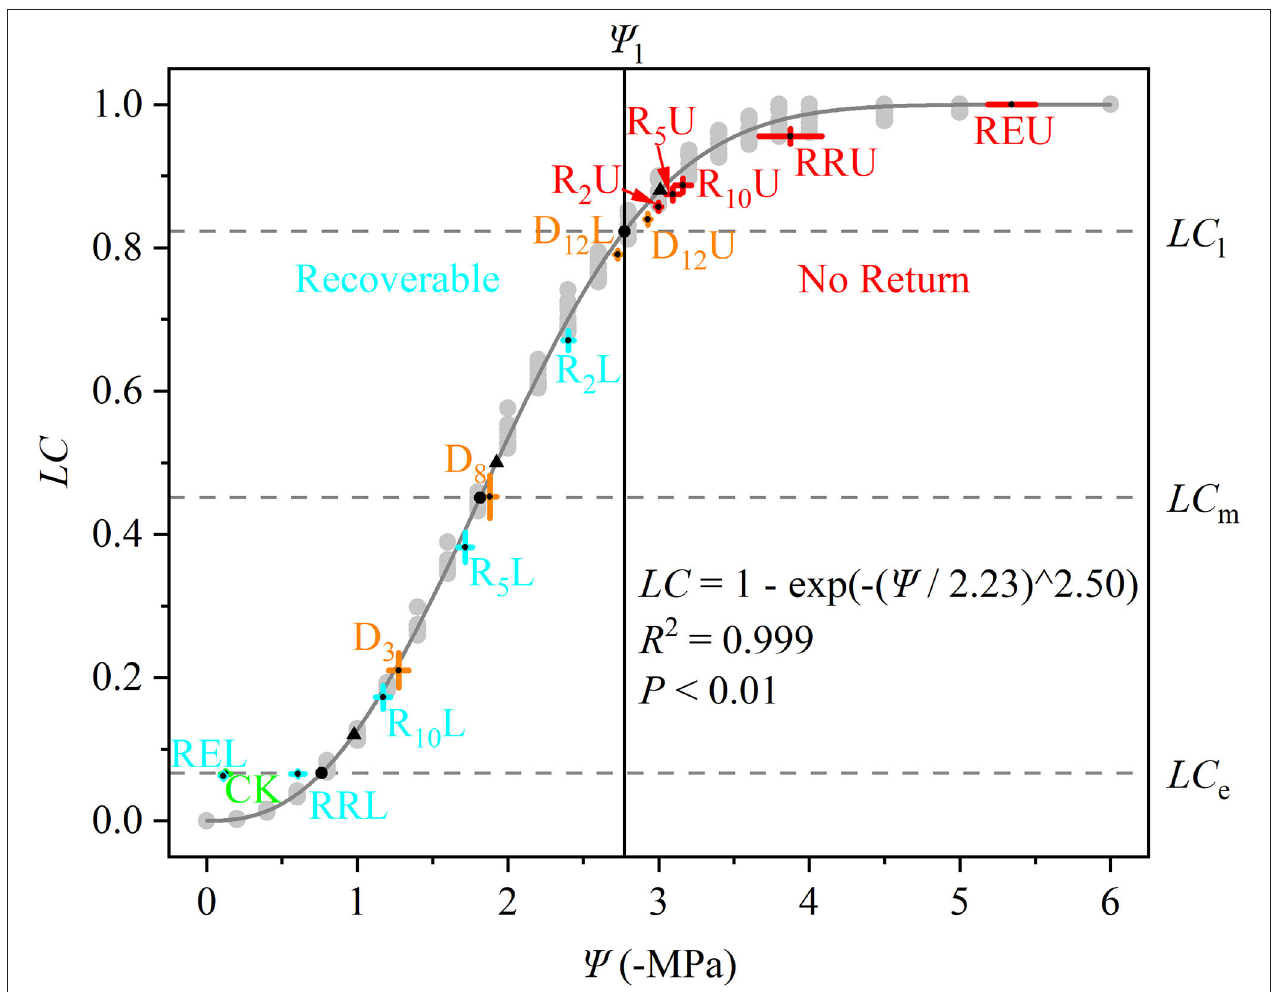
FIGURE 2 | Hydraulic vulnerability curve (gray solid line) for Robinia pseudoacacia , which is fitted from 10 saplings belonging to CK (light gray points). The stem water potential ( Ψ , –MPa) and loss of conductivity ( LC ) for all of the treatments are marked in the figure. The data is represented by the mean ± 1 SE and n = 10. CK, control group; D 3 , mild drought group; D 8 , moderate drought group; D 12 U, upper part of the severe drought group; D 12 L, lower part of the severe drought group; R 2 U, upper part of the 2-day-rewatering group; R 2 L, lower part of the 2-day-rewatering group; R 5 U, upper part of the 5-day-rewatering group; R 5 L, lower part of the 5-day-rewatering group; R 10 U, upper part of the 10-day-rewatering group; R 10 L, lower part of the 10-day-rewatering group; RRU, upper part of the group in which rewatering occurred until rebudding was present; RRL, lower part of the group in which rewatering occurred until rebudding was present; REU, upper part of the group in which rewatering occurred until the end of the experiment; REL, lower part of the group in which rewatering occurred until the end of the experiment. Ψ e , Ψ m , and Ψ l are bottom up in the black circles. In addition, LC e , LC m , and LC l (gray dash lines) are the corresponding LC of the Ψ e , Ψ m , and Ψ l . Black triangles indicate Ψ 12 , Ψ 50 , and Ψ 88 . Ψ at Ψ l (black vertical solid line) separates the curve into two parts; the left part is recoverable, while the right part cannot be recovered.